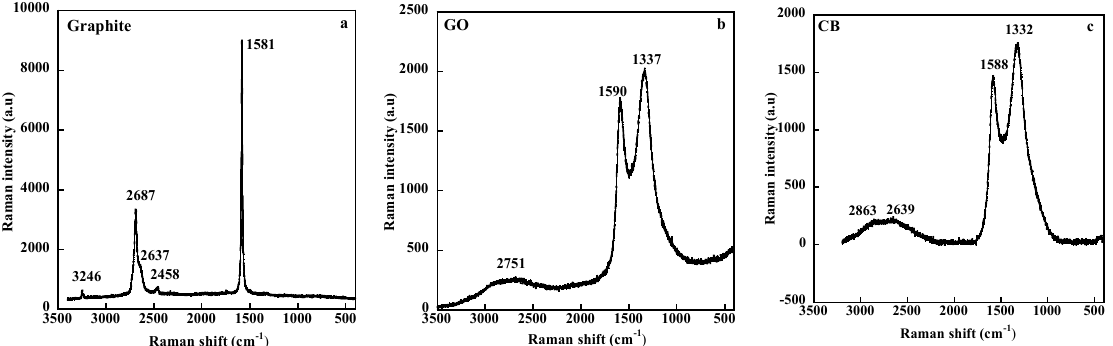
Figure 12. Raman spectra of graphite ( a ), graphene oxide ( b ) and carbon black ( c ) excited at 633 nm.